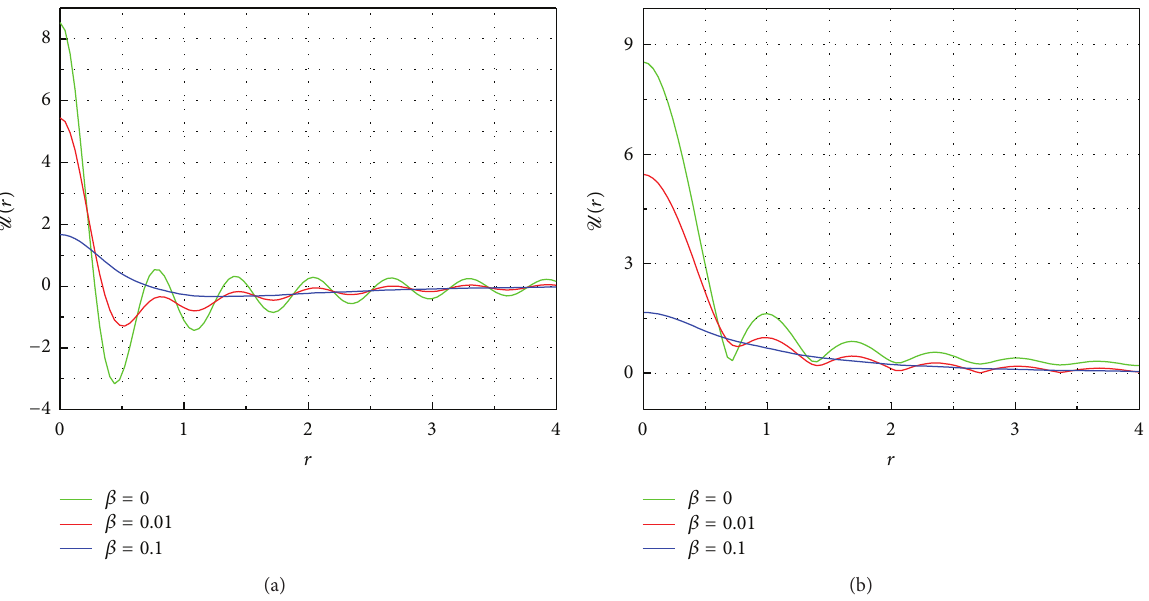
Figure 1: Real part (a) and norm (b) of U (𝑟) versus 𝑟 for different values of 𝛽 .